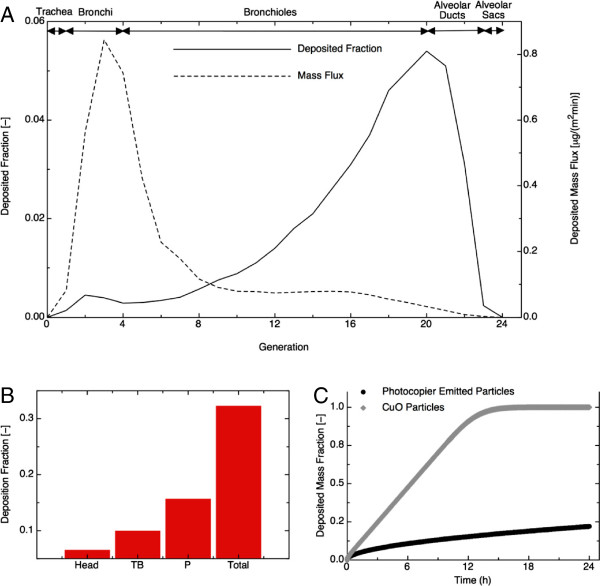
Modeled deposited mass fraction and the mass flux (μg/m2) for the different regions of the lung (shown as generation number). (A) Model calculations of deposition mass flux (left axis) and deposition fraction (right axis) as a function of generation number. (B) Deposition fraction in total lung for head, tracheobronchial region (TB) and pulmonary region (P). (C) In-vitro dosimetry: delivered mass fraction as a function of time for photocopier emitted - and CuO nanoparticles.